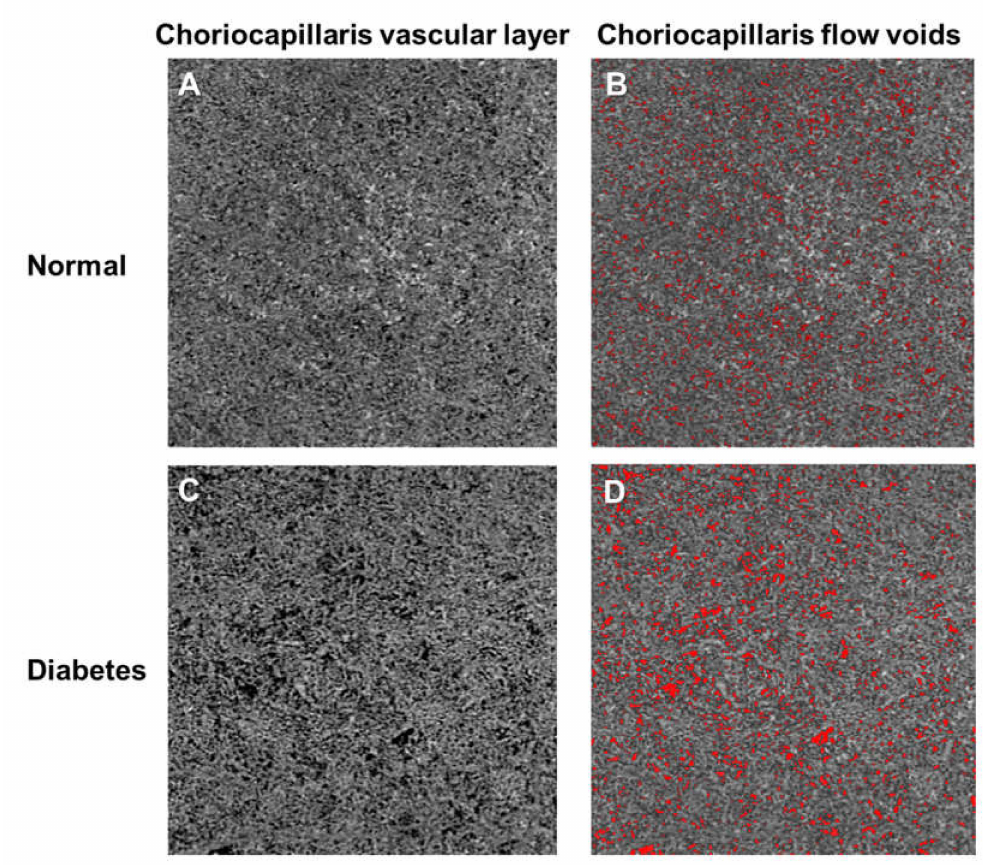
Figure 7. Optical coherence tomography angiography (OCTA; 3 × 3 mm area) and color-coded maps indicating regions of flow voids ( B , D ; labelled as red) of a choriocapillaris vascular layer of a healthy control individual (Top panel; A , B ) and a diabetic (Bottom panel; C , D ), showing the presence of more and larger sized choriocapillaris flow voids in a diabetic eye ( D ; labelled as red). The presence of flow voids can be seen as areas of dark regions in the angiogram ( A , C ) and are labelled as red in the color-coded map ( B , D ). Figures were created after removal of projection